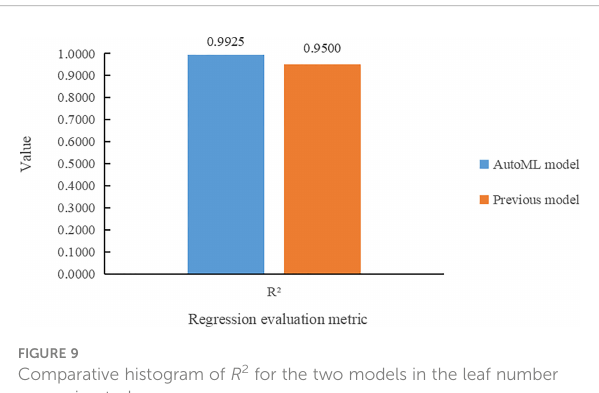
FIGURE 9 Comparative histogram of R 2 for the two models in the leaf number regression task.